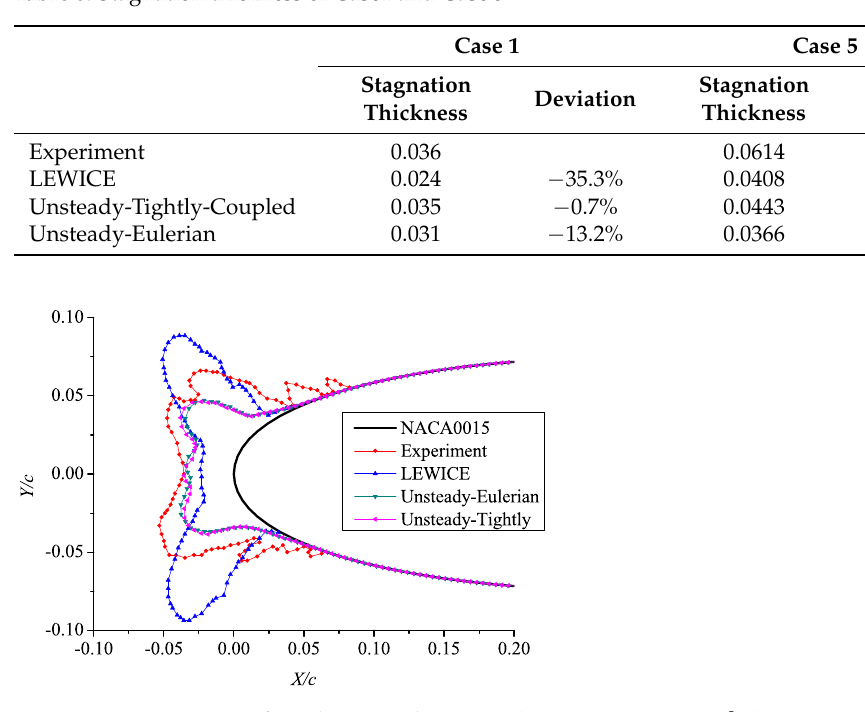
Table 8. Stagnation thickness of Case1 and Case 5.